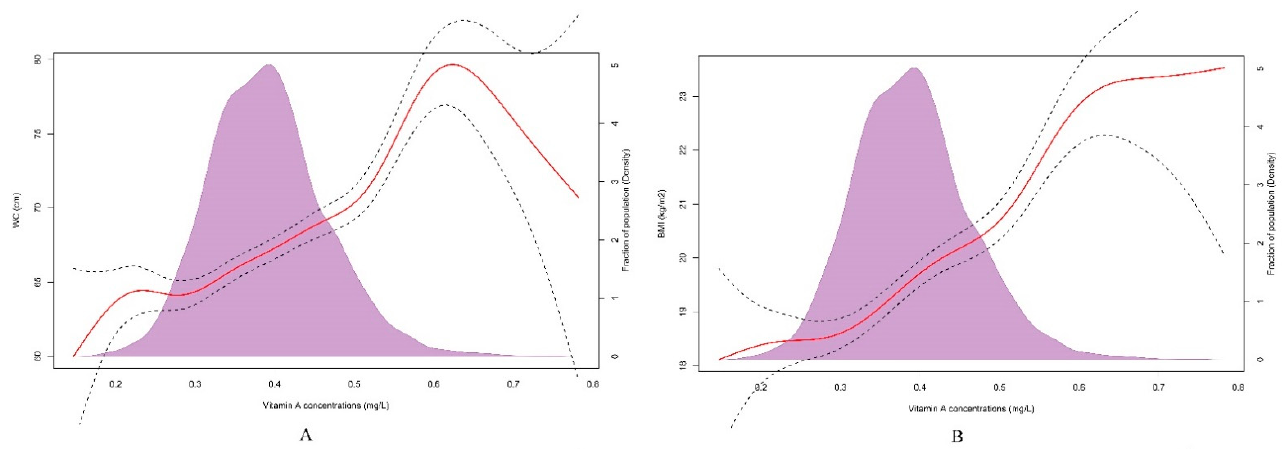
Figure 1. Dose-response curves with 95% confidence interval (CI) were modelled for the associa- tions of serum vitamin A and numerous metabolic risk factors by the generalized additive model (GAM). ( A ). the association between vitamin A concentrations and WC. ( B ). the association between vitamin A concentrations and BMI. ( C ). the association between vitamin A concentrations and TG. ( D ). the association between vitamin A concentrations and TC. ( E ). the association between vitamin A concentrations and LDL. ( F ). the association between vitamin A concentrations and SUA. Abbre- viations: waist circumference (WC), body mass index (BMI), triglyceride (TG), total cholesterol (TC), low-density lipoprotein cholesterol (LDL), serum uric acid (SUA).